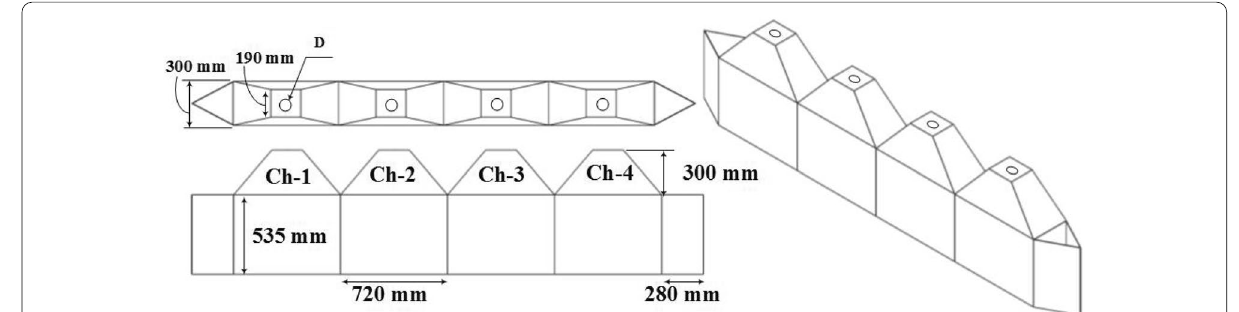
Figure 2 MC-OWC device shape and